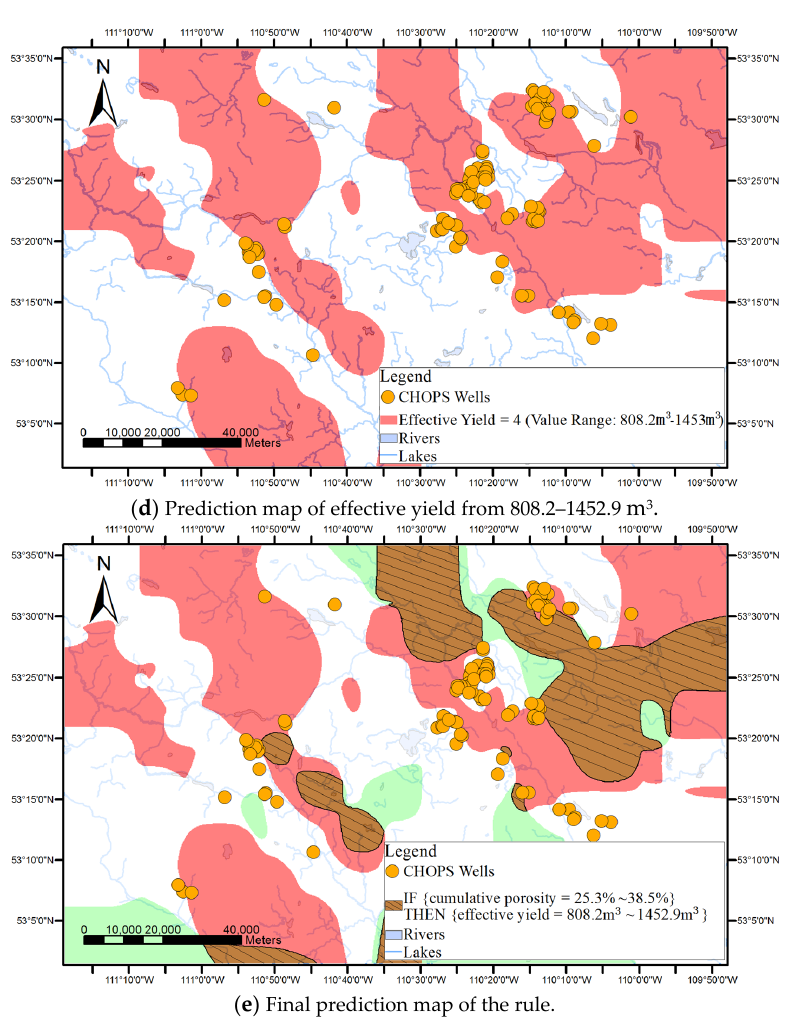
( e ) Final prediction map of the rule. Figure 9. Surface-based geovisualization based on Spline interpolation of IF {cumulative porosity = 25.3%–38.5%} THEN {effective yield = 808.2–1452.9 m 3 }.